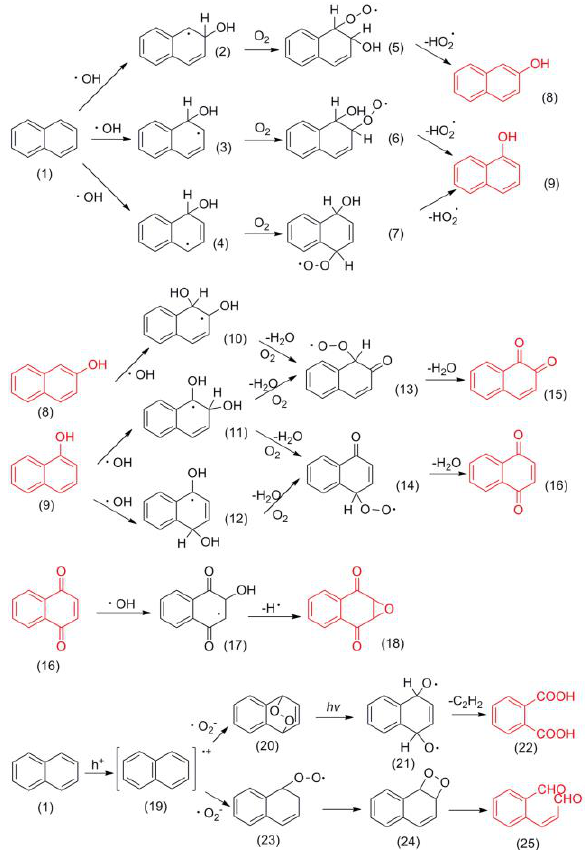
Figure 10. Possible pathways for the formation of the main intermediates of naphthalene degradation.